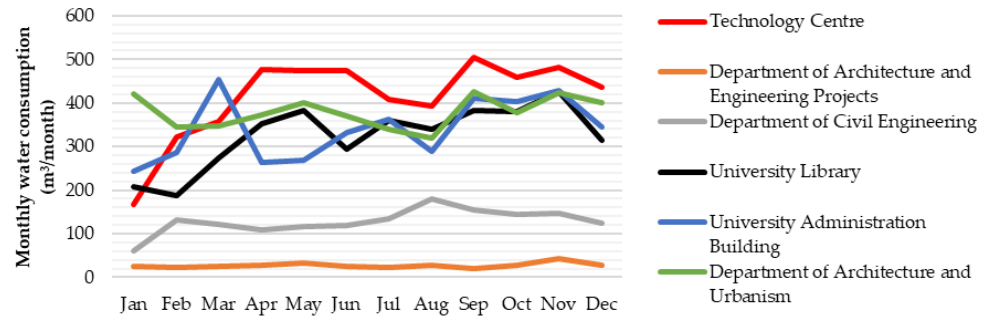
Figure 5. Monthly average water consumption in the six buildings.